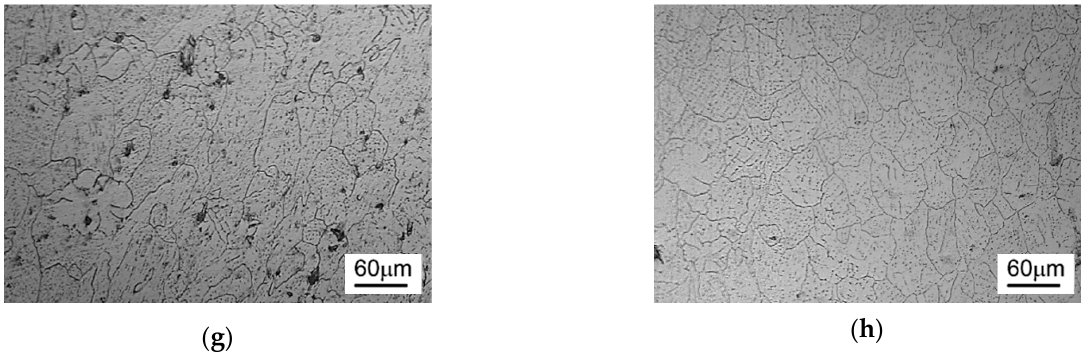
Figure 2. Micrographs of experimental aluminum alloys: ( a ) commercial purity Al, ( b ) Al-0.02Zr, ( c ) Al-0.04Zr, ( d ) Al-0.06Zr, ( e ) Al-0.08Zr, ( f ) Al-0.10Zr, ( g ) Al-0.12Zr and ( h ) Al-0.14Zr.